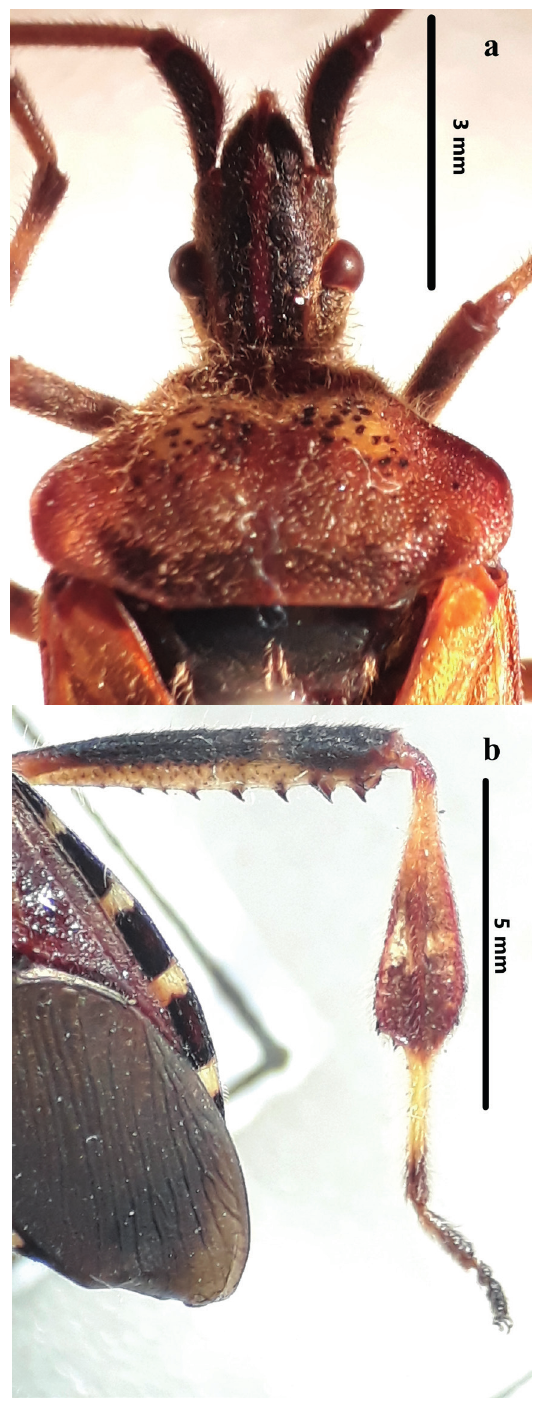
Figure 2 - Key visual expedite diagnostic features of an adult of Leptoglossus occidentalis. a) Overall body colour dark reddish brown with pronotum and venter mottled with numerous piceous spots with their humeral angle broadly rounded; b) the outer tibial dilations entire not dentate, weakly wider than the inner